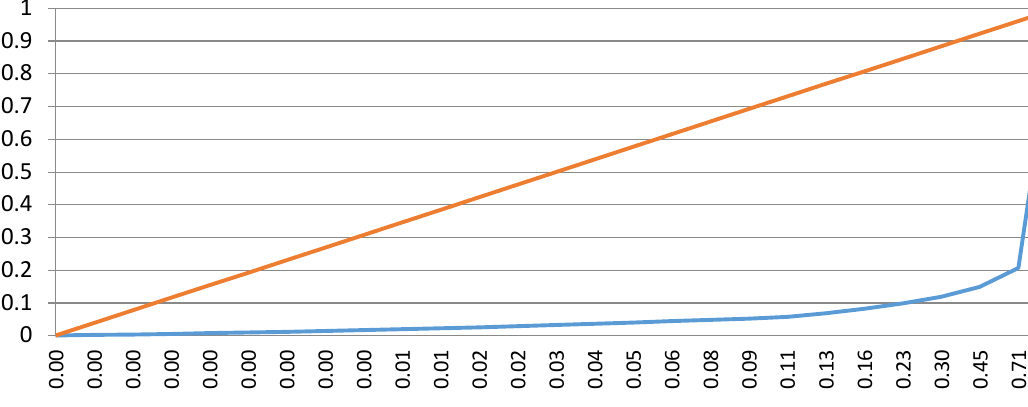
Figure 4. Lorenz curve for 2017